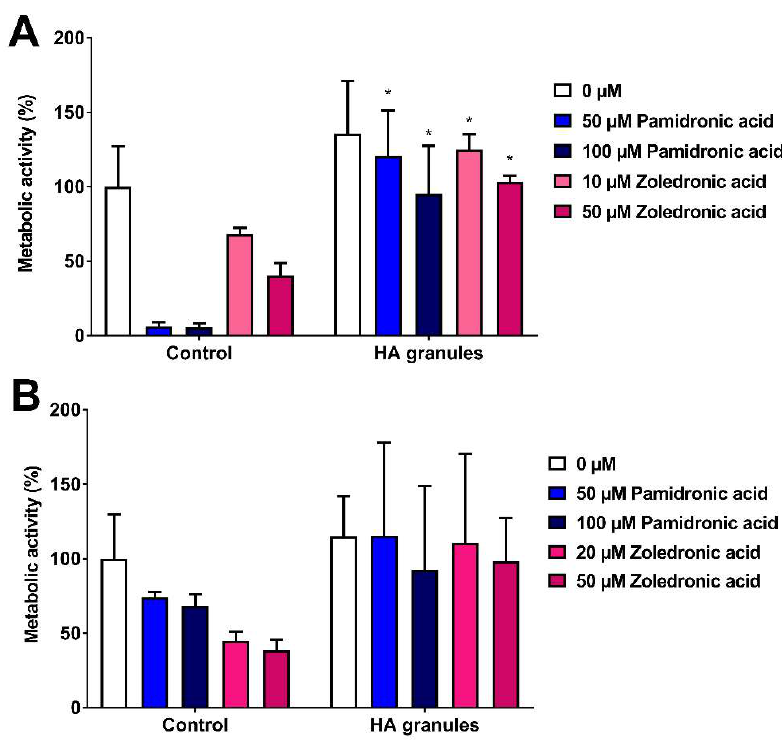
Figure 4. ( A ) Human oral fibroblast and ( B ) immortalised human oral keratinocyte metabolic activity over 72 h in the presence of pamidronic acid and zoledronic acid, measured by MTT assay. Bisphosphonates had previously been incubated for 72 h with hydroxyapatite (HA) granules; bisphosphonates incubated with no hydroxyapatite used as a control. Values normalised to control 0 µM. N = 3, n = 3. Error bars = SD. Significance against control indicated by *p ≤ 0.05.